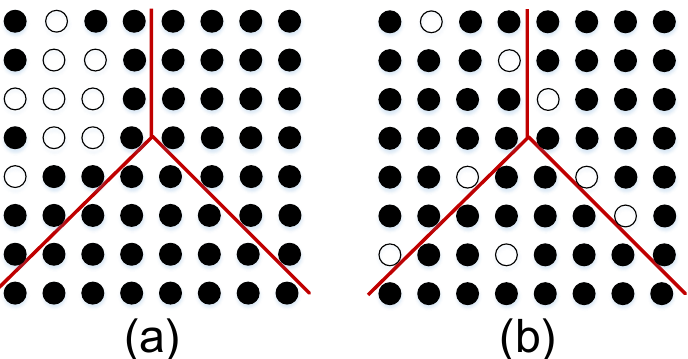
Figure 3. Two distributions of sparse entries in an 8 × 8 frame. ( a ) Concentrate distribution of outliers, ( b ) Dispersive distribution of